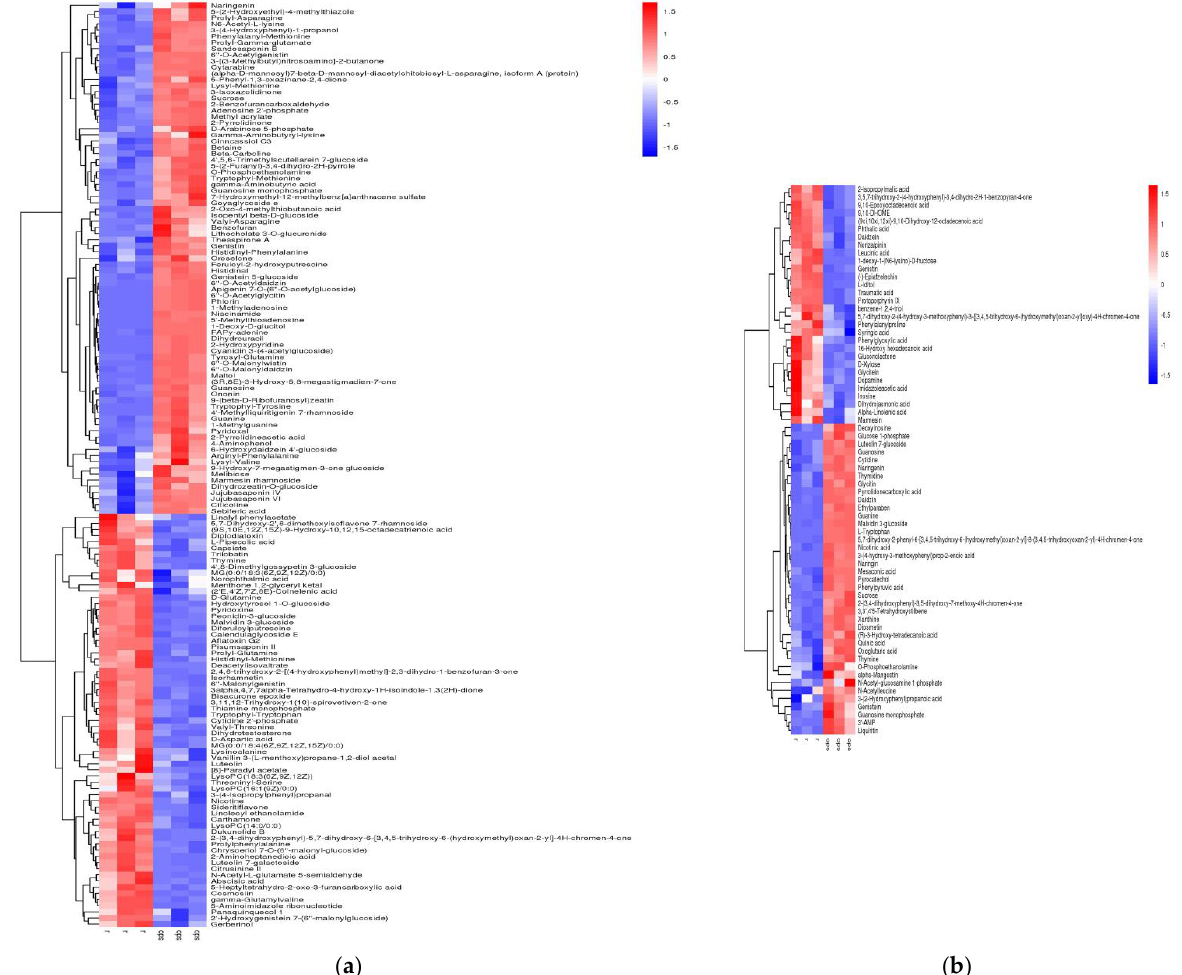
Figure 4. Heat map of hierarchical cluster analysis of differential metabolites of raw and steamed black beans. ( a ) Positive ion mode. ( b ) Negative ion mode.